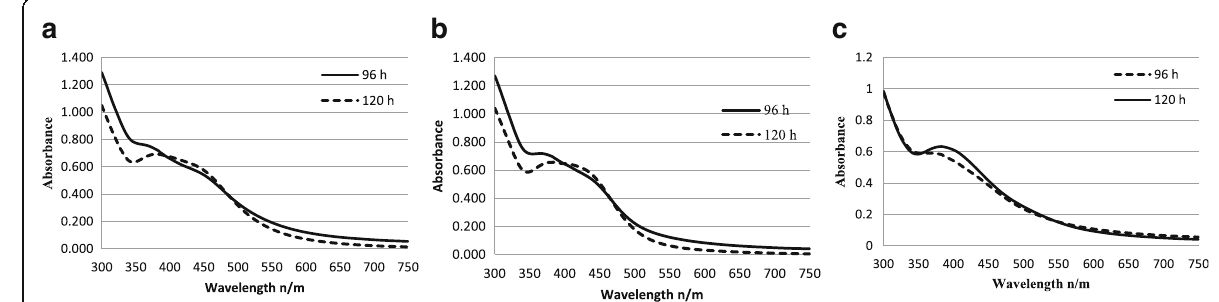
Fig. 3 a – c UV – visible absorption spectra of extracellularly synthesized AgNPs by Trichoderma longibrachiatum with fungal biomass 10g ( a ), 15 g ( b ) and 20g ( c